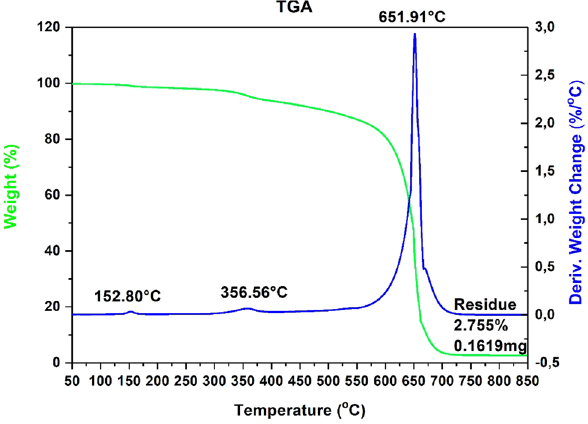
Figure 9: TGA thermogram for modi fi ed carbon CNTs after oxidation reaction.